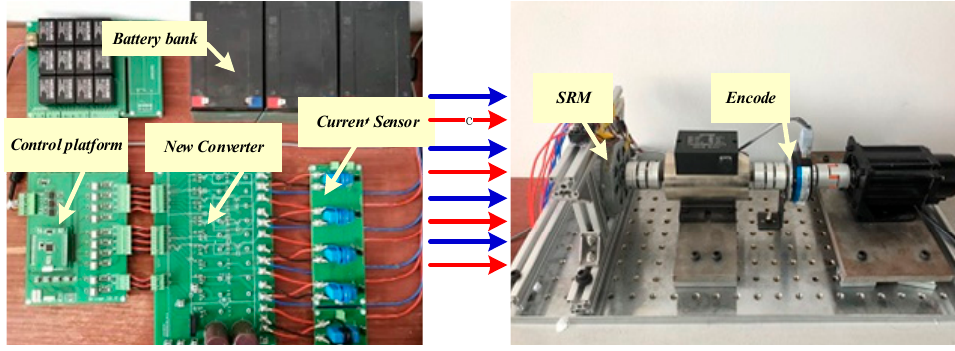
Figure 17. Experimental platform.